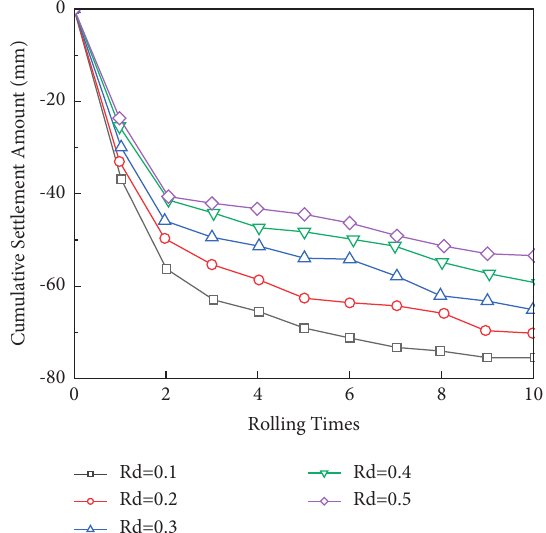
Figure 17: Cumulative settlement-compactor pass responses for fillings with different roundnesses.